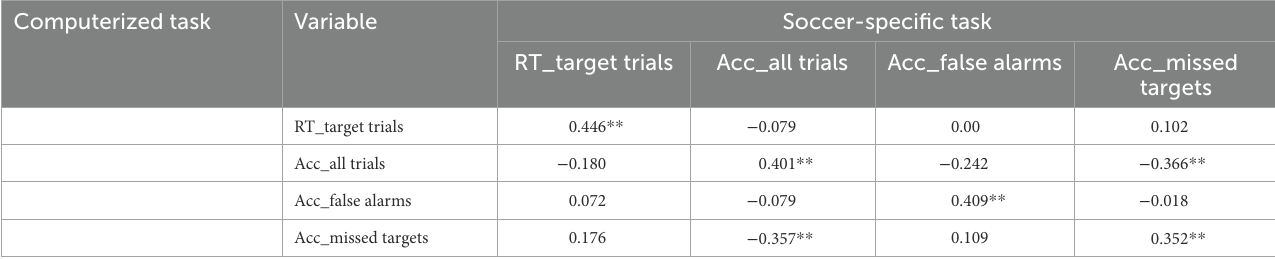
TABLE 3 Correlations for response time and accuracy values between computerized and soccer-specific 3-back task. Computerized